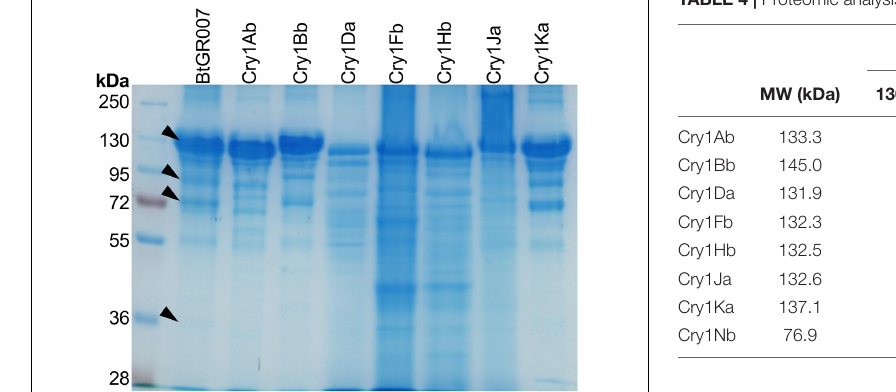
TABLE 5 | Toxicity of parasporal crystals against insect